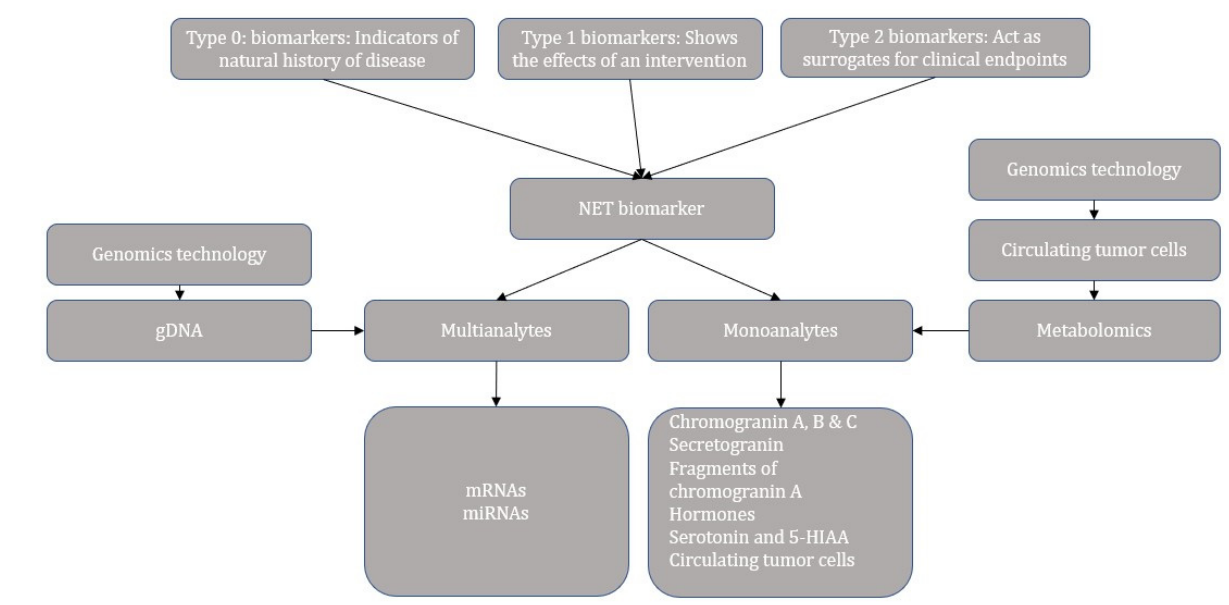
Figure 1. Categories and progress overview of neuroendocrine tumor